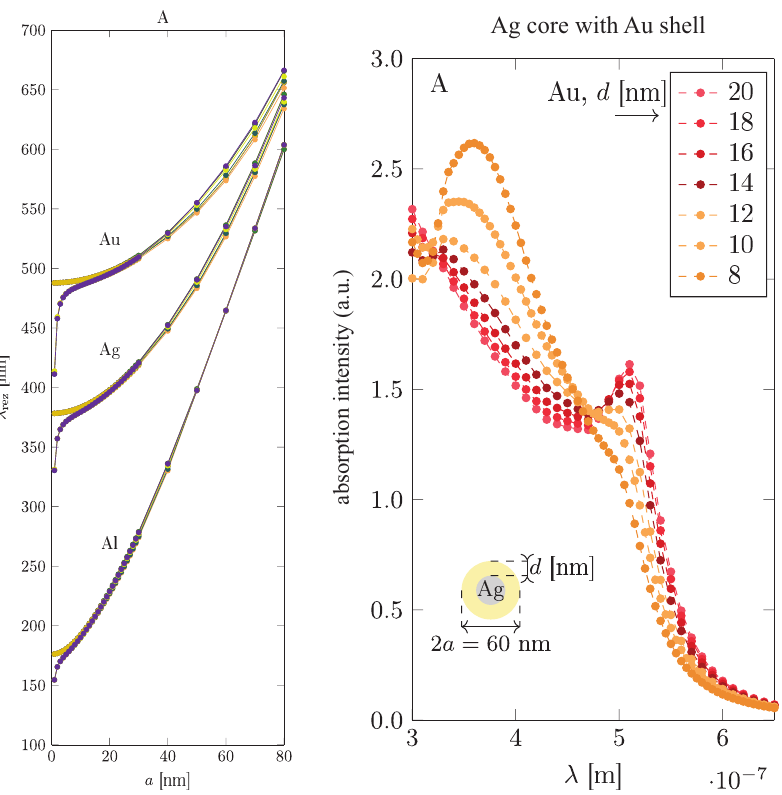
Figure 6. ( left ) Dependence of the surface plasmon resonance on material. A strong reduction in the resonance wavelength can be achieved through the application of Fe or Al nanoparticles (small splitting in resonance curves is related to various approximations of plasmon damping used in the simulation). ( right ) By adjusting the shell-core bi-metal nanoparticle composition, it is possible to adjust precisely the plasmon resonance in metallic components to its optimal value for the plasmon photovoltaic effect in perovskite cells with varied gorbidden gaps [45] (Comsol simulation).